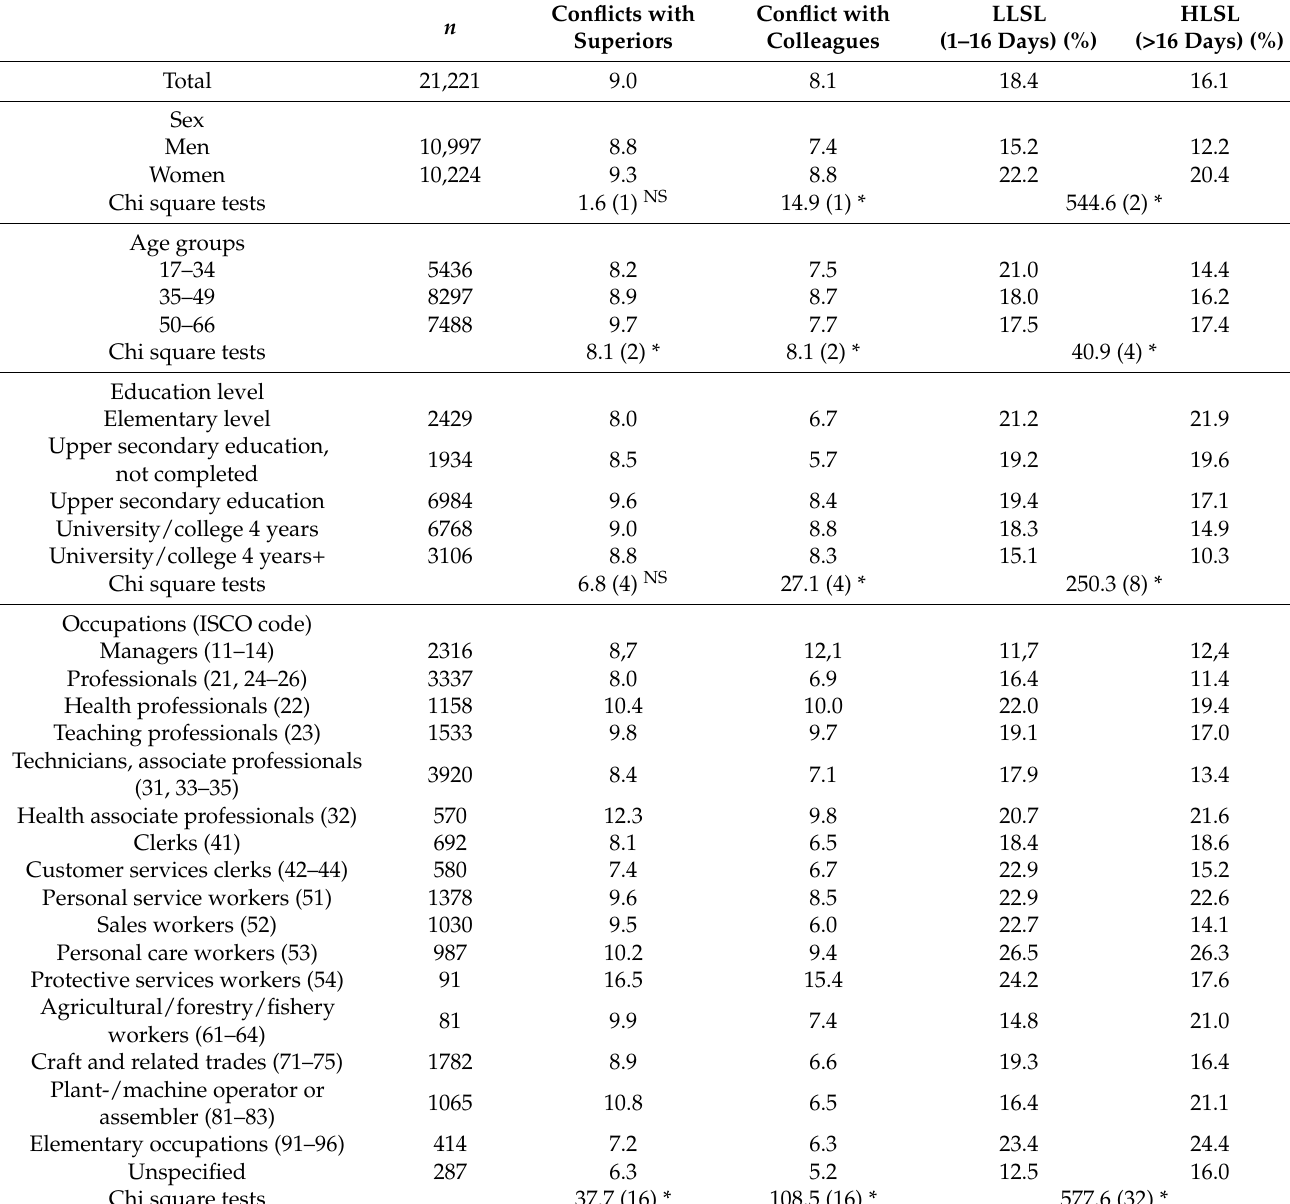
Table 2. Prevalence of workplace conflicts and sick leave by sex, age, education and